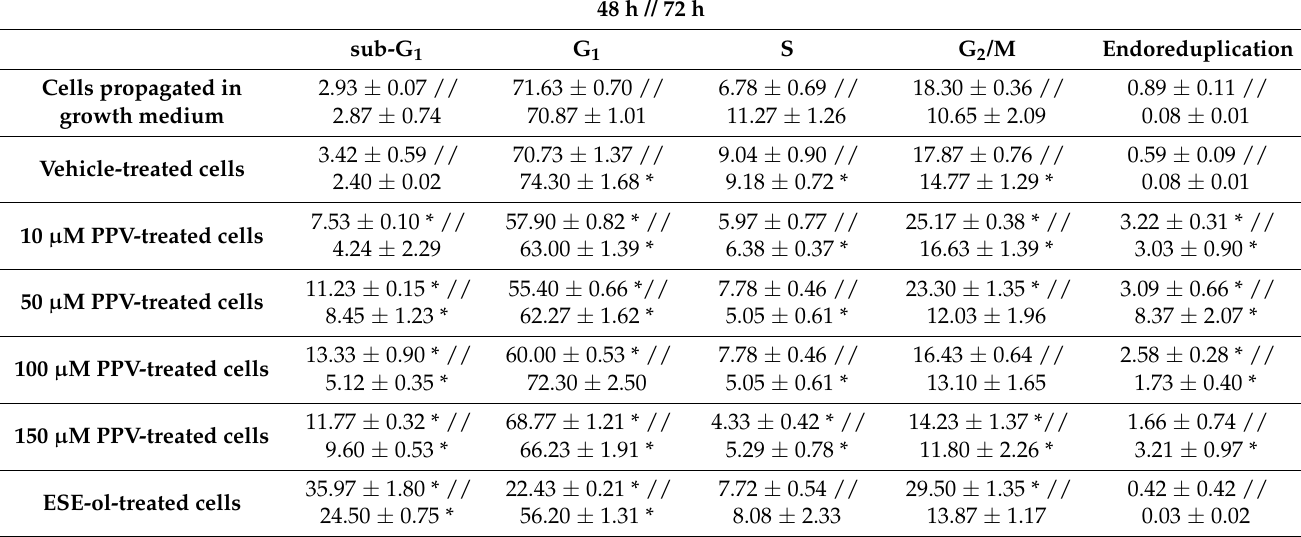
Table 2. The effects of PPV on cell cycle and cell death induction as a percentage of cells in each phase of the cell cycle on A549 cells at 48 h // 72 h. Statistical significance is represented by an * when using the Student t -test with a p value of 0.05 compared to cells propagated in growth medium.